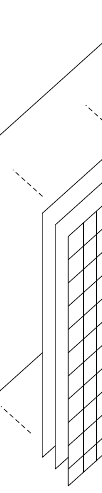
Figure 1. Word embedding.